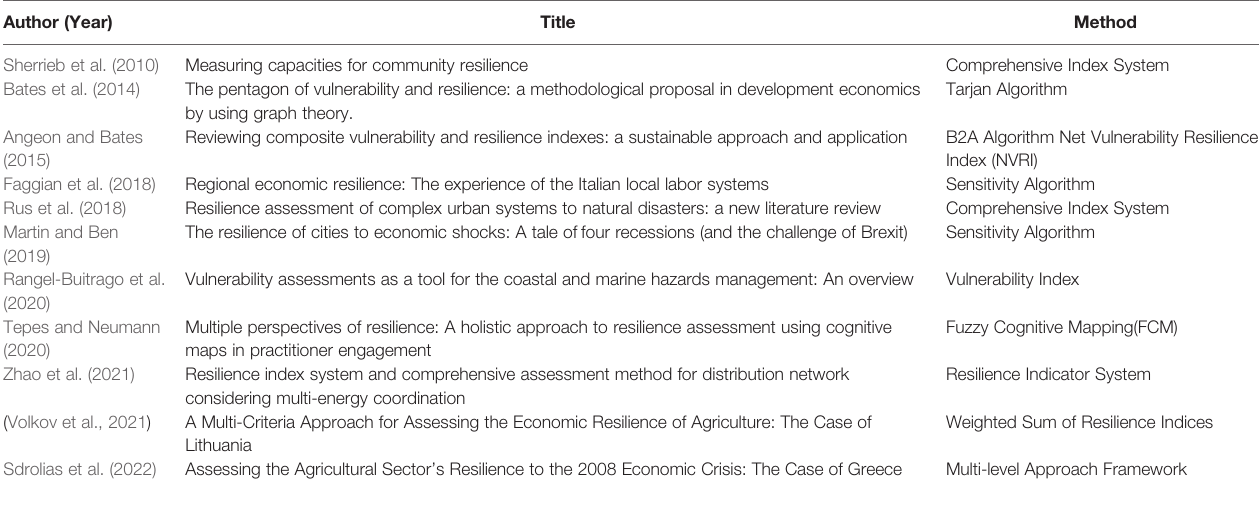
TABLE 1 | The summary of the existing method for assessing